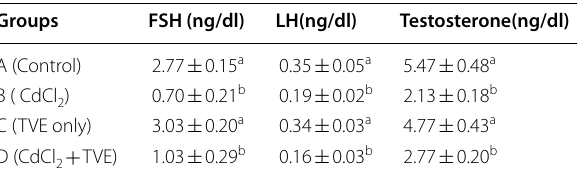
Table 2 Serum concentration of reproductive hormones of the experimental groups of rats